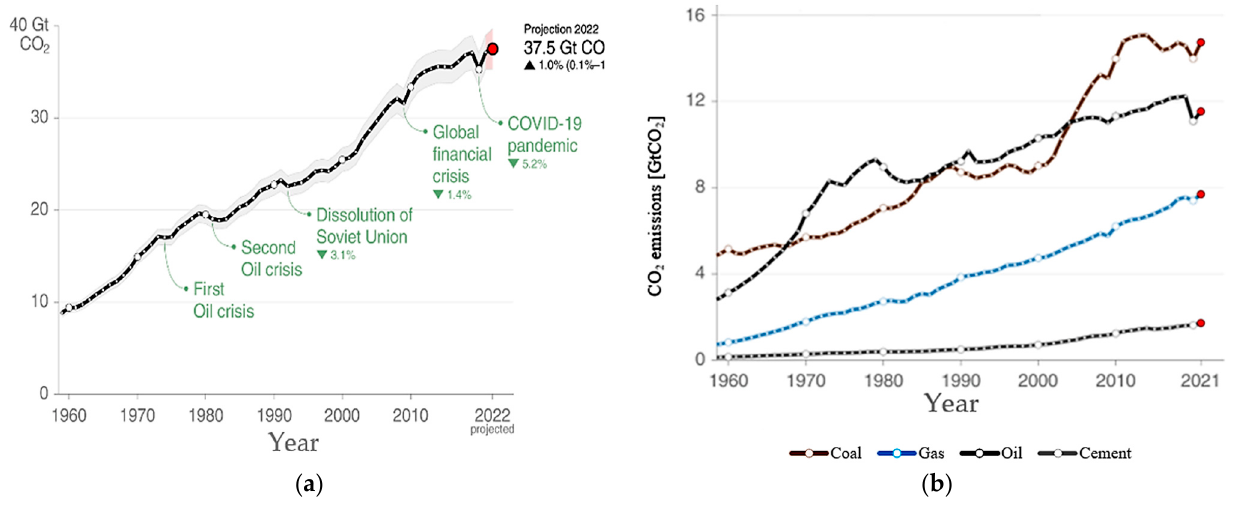
Figure 3. Emissions of CO 2 from fossil fuels from 1960 to 2021: ( a ) global, ( b ) by source of fuel